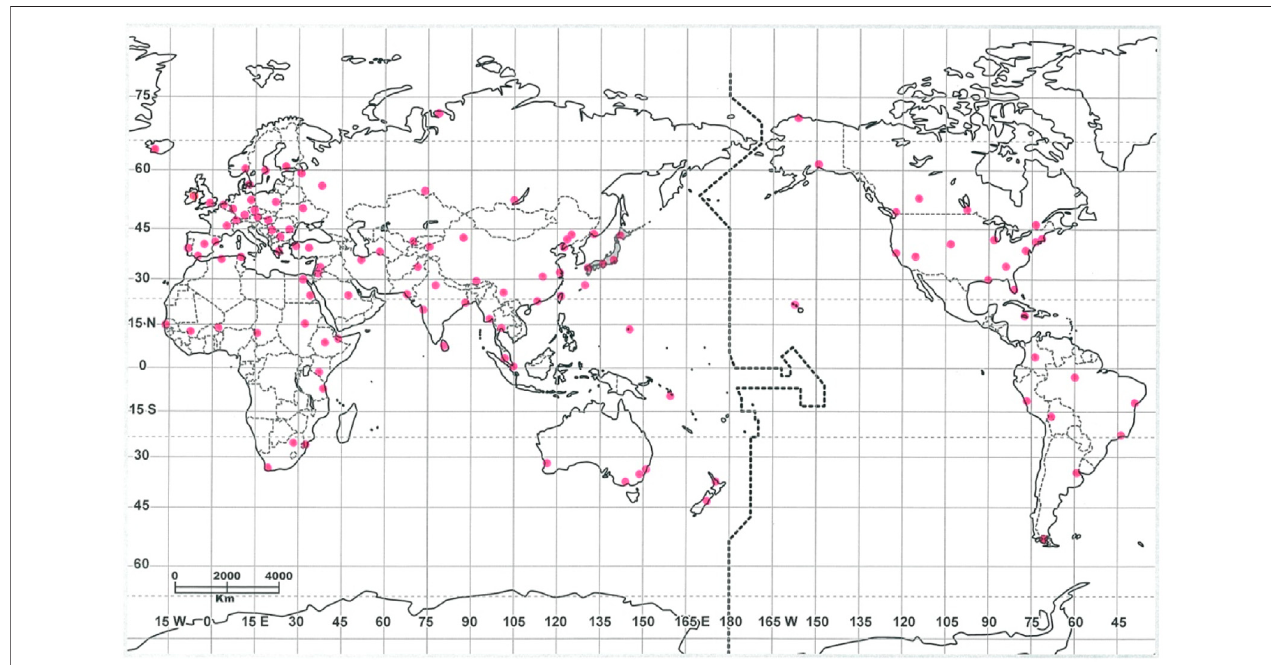
FIGURE 1 | The plots of observational stations (pink dots) in the world